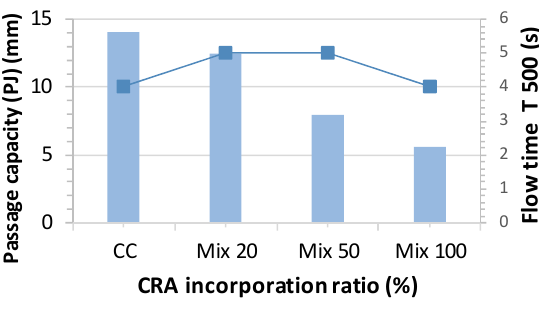
Figure 12. PJ and T 500